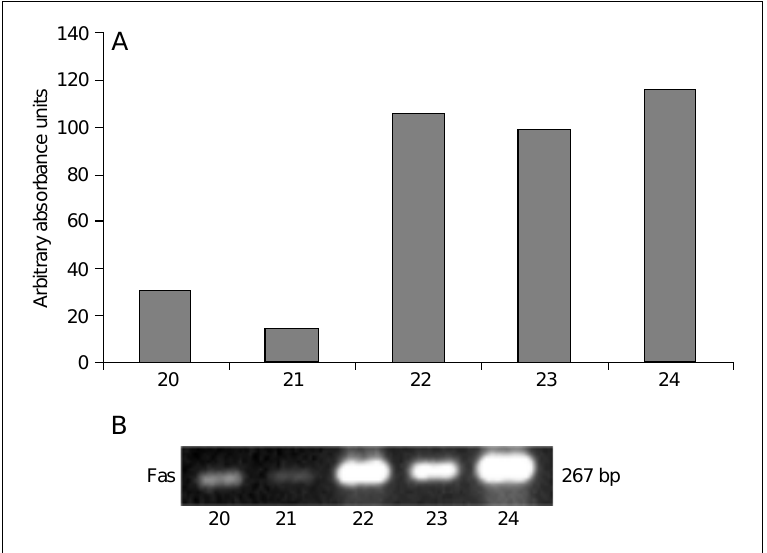
Figure 2. Individual levels of Fas expression in control NOD mice at the 32nd week of life. A , Results of semiquantitative measurements expressed as arbitrary absorbance units. B , Representative results of PCR analyzed in 1.5%